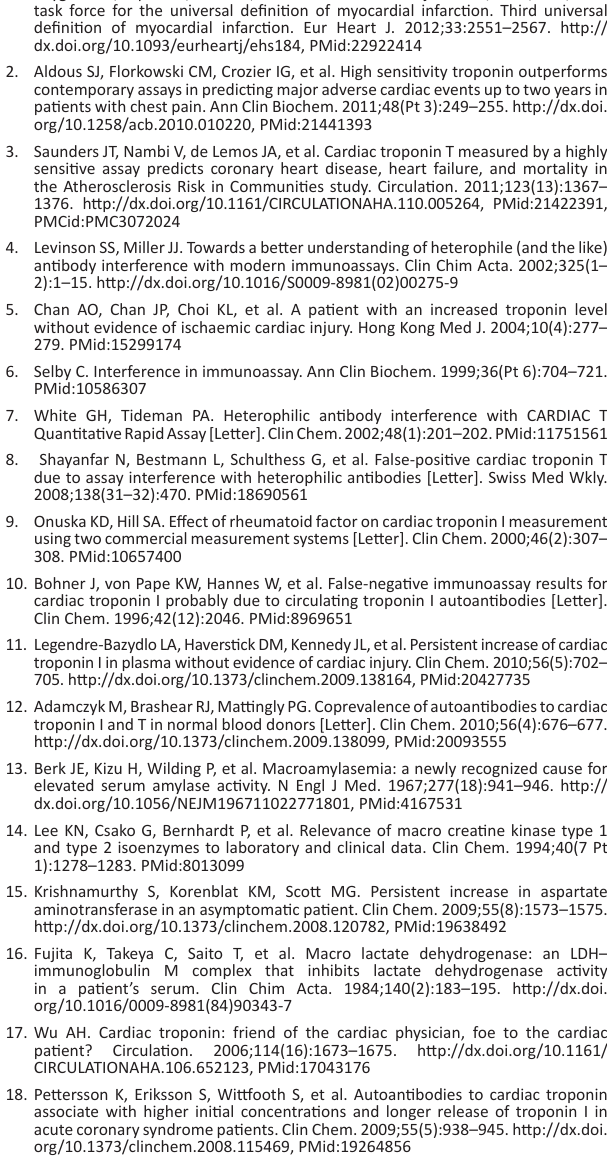
mouse anti-cTnT-gold